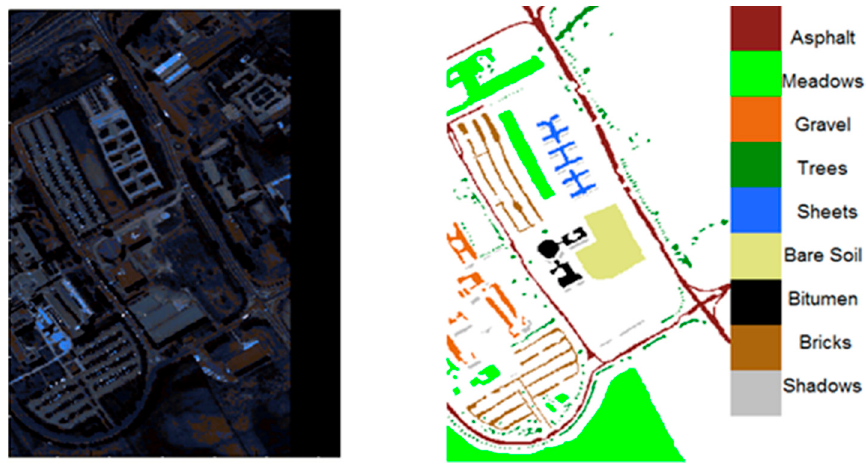
Figure 5. Hyperspectral data of Pavia University.